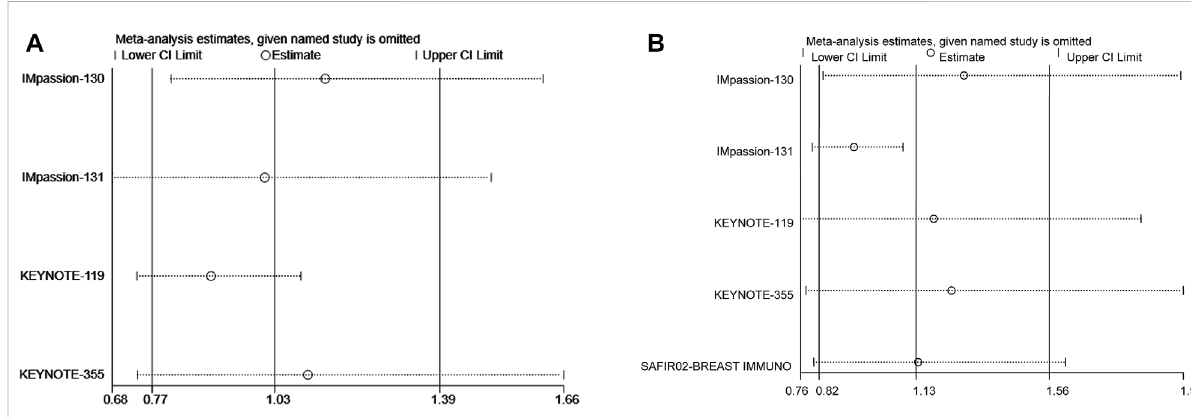
FIGURE 7 Sensitivity analysis (A) for progression-free survival and (B) for overall survival.